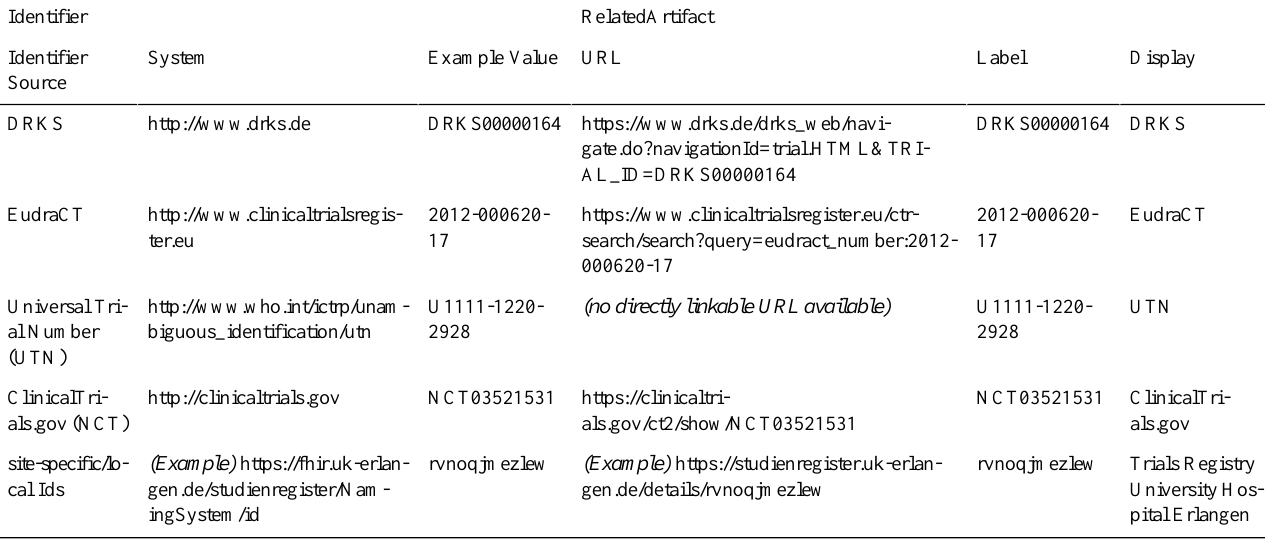
Table 2. Mapping between various source registry identifying numbers and ResearchStudy.identifier systems and values. The mapping to ResearchStudy.relatedArtifact is also